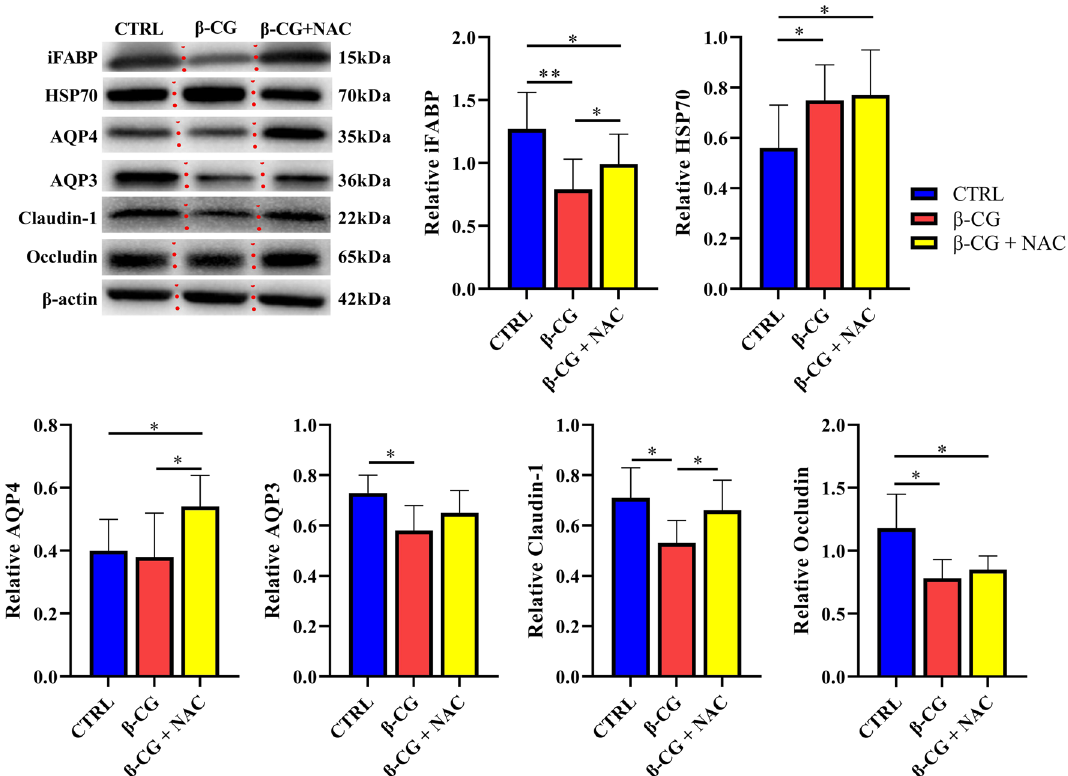
Figure 7. Protein abundances of AQP3, AQP4, iFABP, claudin-1, occludin, and HSP70 in the jejunal mucosa of piglets (full length blots are shown in Supplementary Figure S1–S6). Approximately 100 mg of jejunal mucosal samples were powdered and homogenized in lysis buffer. After centrifugation, the mucosal samples were separated by 7.5% (for occludin and HSP70), 10% (for β-actin and claudin-1), or 12% (for iFABP, AQP3 and AQP4) SDS-PAGE and electroblotted onto the polyvinylidene difluoride membrane. Thereafter, membranes were incubated with a primary antibody and a secondary antibody as described in MATERIALS AND METHODS. Data are mean ± SEM, n = 8. * P < 0.05, ** P < studies, β-CG challenge enhanced enterocyte apoptosis and decreased the jejunal VH and VH/CD ratio. However, no significant differences were observed in the jejunal VH or VH/CD ratio between the control and β-CG + NAC groups, indicating that these adverse effects could be mitigated by NAC supplementation. The reason why NAC inhibits β-CG-induced the apoptosis of intestinal epithelial cells (Fig. 5) is unclear. An in vitro study revealed that addition of NAC to cell culture medium could enhance enterocyte growth and protein synthesis 18 . Moreover, although NAC administration did not alter the levels of plasma DAO and iFABP, both of which may serve as bio- markers of gut mucosal injury 32,33 . Additionally, the abundance of iFABP in the small intestine was significantly increased by NAC supplementation in β-CG-challenged pigs, further substantiating the notion that NAC can stimulate global and specific syntheses of proteins by enterocytes. Of note, NAC may regulate iFABP expression in enterocytes at both transcriptional and translational levels since the abundances of jejunal iFABP mRNA and protein were augmented in β-CG-challenged piglets that received NAC administration. Furthermore, NAC may also protect the intestinal barrier function in piglets because its supplementation attenuated the decreases in jejunal claudin-1 protein abundance and jejunal mRNA levels for claudin-1 and occludin in β-CG-challenged piglets. By using the intestinal injury model of LPS-challenged piglets, we have reported the elevations in pro- tein abundances of jejunal occludin and claudin-1 by NAC administration 17 . Collectively, NAC treatment could improve intestinal integrity and function in piglets challenged by β-CG. In healthy pigs, D-xylose is readily absorbed by the small intestines. However, under conditions of mal- absorption, the entry of D-xylose from the intestinal lumen to the portal vein is impaired, and therefore the concentrations of D-xylose in both blood and urine are reduced 34 . Moreover, Papadia et al . 35 reported that the plasma concentration of citrulline (which is exclusively synthesized from glutamine and proline by enterocytes in most mammals including humans and pigs) was a reliable marker for the mass and metabolic activity of the small bowel in short bowel patients. Therefore, plasma D-xylose and citrulline levels can serve as indicators of the ability of the small intestine to absorb nutrients 34–36 . Our results that NAC increased plasma citrulline concentra- tions and attenuated the decrease in D-xylose concentrations in the plasma of β-CG-challenged piglets indicated improvements in intestinal mass/metabolic activity and absorptive function in response to oral administration of NAC. Certainly, the precise changes in absorptive function needs to be measured in further applied studies. By using porcine models of intestinal injury induced by LPS challenge and porcine epidemic diarrhea virus